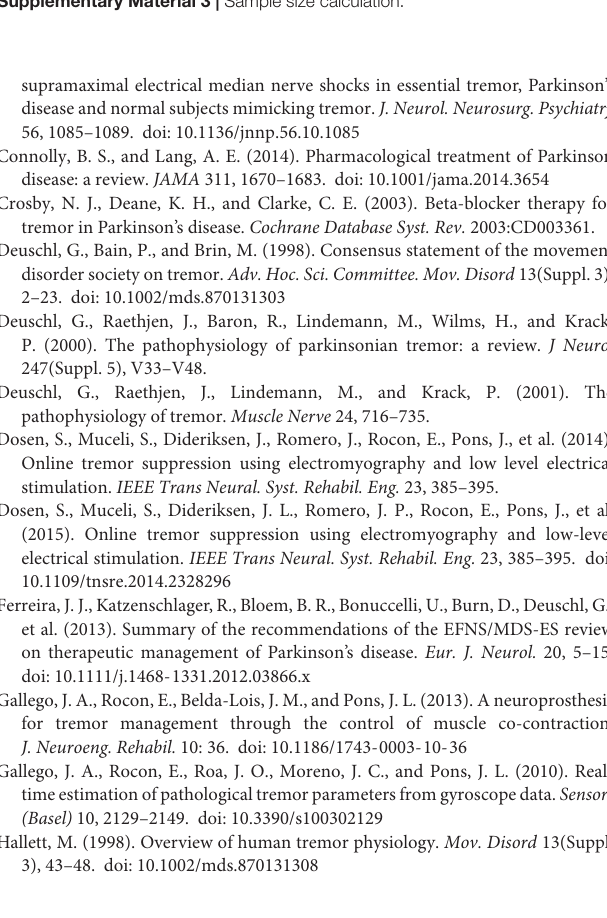
Supplementary Figure 1 | The CONSORT flowchart provides a complete detailed flowchart of this single-arm study. Supplementary Figure 2 | The complex interaction between central and peripheral (local mechanical-reflex) mechanisms for tremorogenesis. Representation of the origination of PD tremor that develops from the complex interaction between central oscillators and peripheral mechanisms. Bold lines represent the tremor control commanded from central oscillators to peripheral mechanisms Dashed lines represent feedback loops from peripheral mechanisms back to central control oscillators.